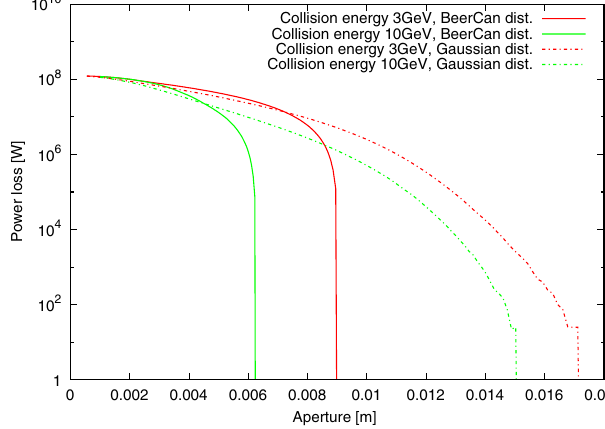
FIG. 15. (Color) Power loss at a given aperture and energy with the initial Gaussian distribution and Beer-Can distribution, high- energy setup (10 GeV collision energy).